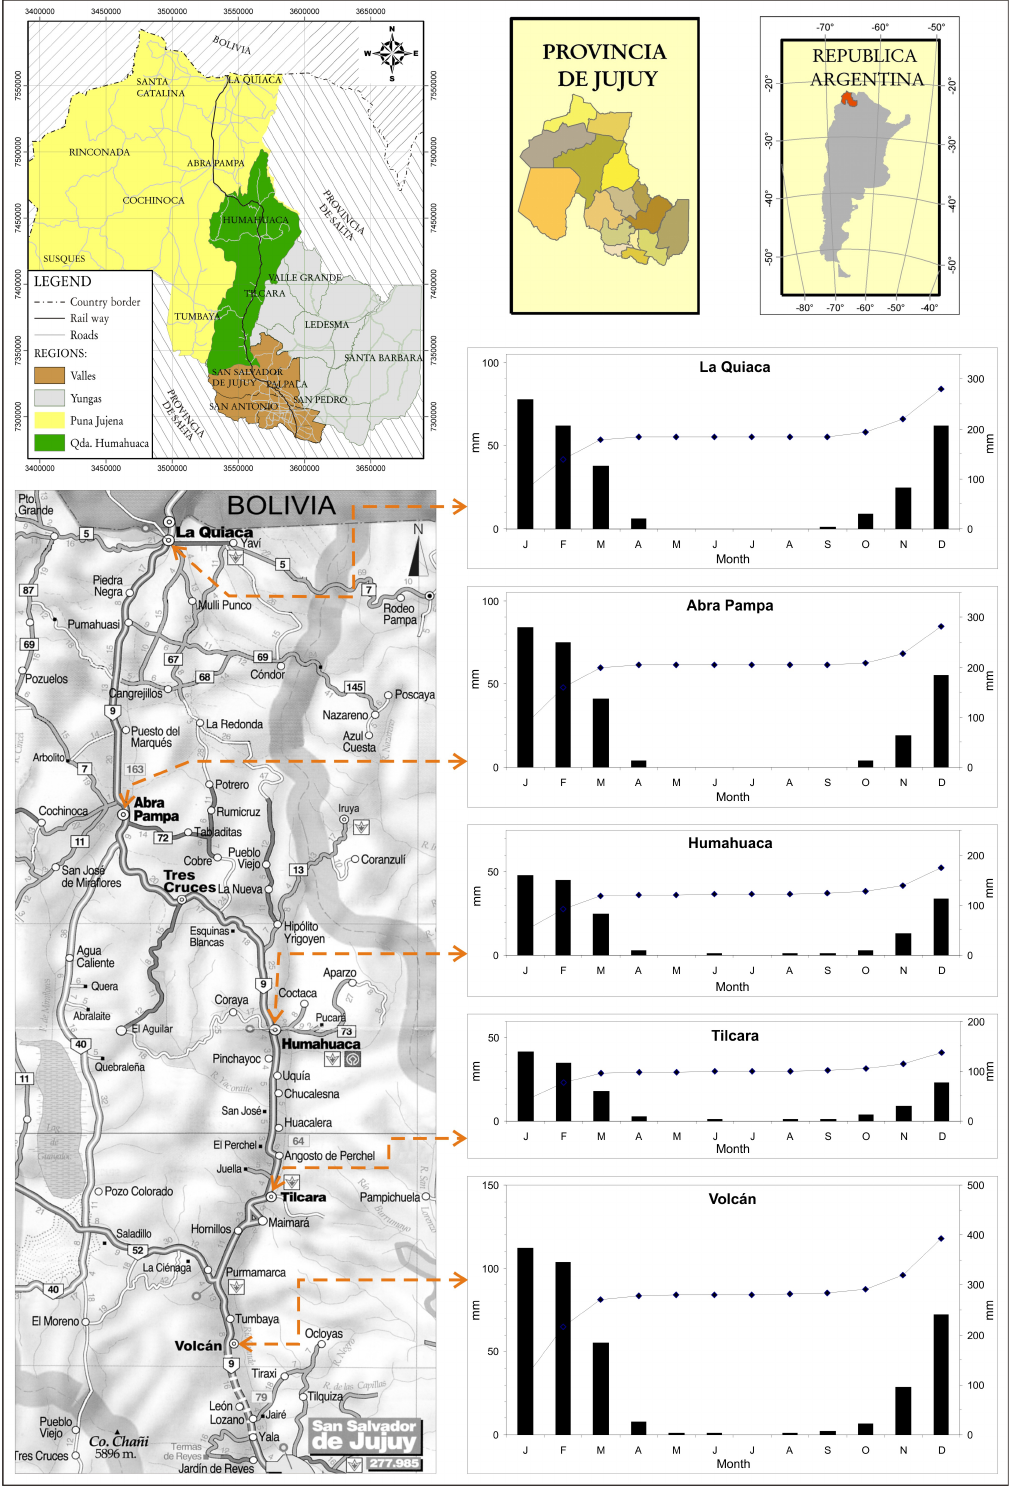
Fig. 1. Location map of Northwest Argentina. The Quebrada de Humahuaca stretches across the Tropic of Capricorn. Monthly rainfall in the period 1934–1990 in the Quebrada de Humauaca and Puna Jujena Regions. Data are derived from the National Meteorological Survey and from the Ferrocaril General Belgrano. Main roads, including Ruta Nacional n. 9 Panamericana, are indicated on the